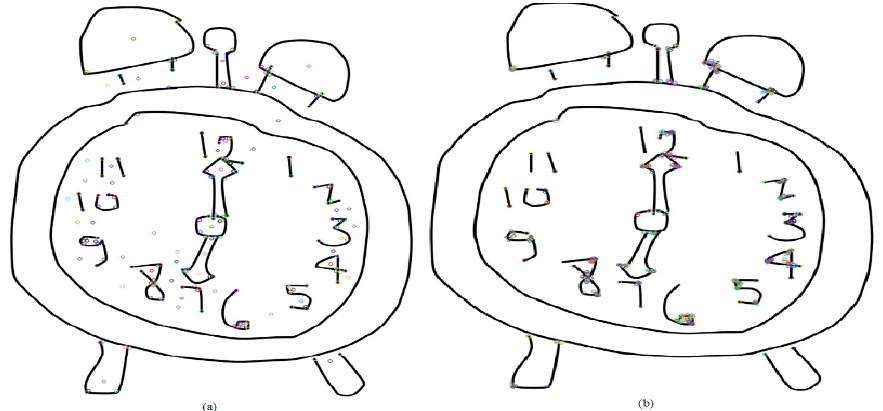
Figure 17. Extracted keypoints using ORB for the training image of each pair.